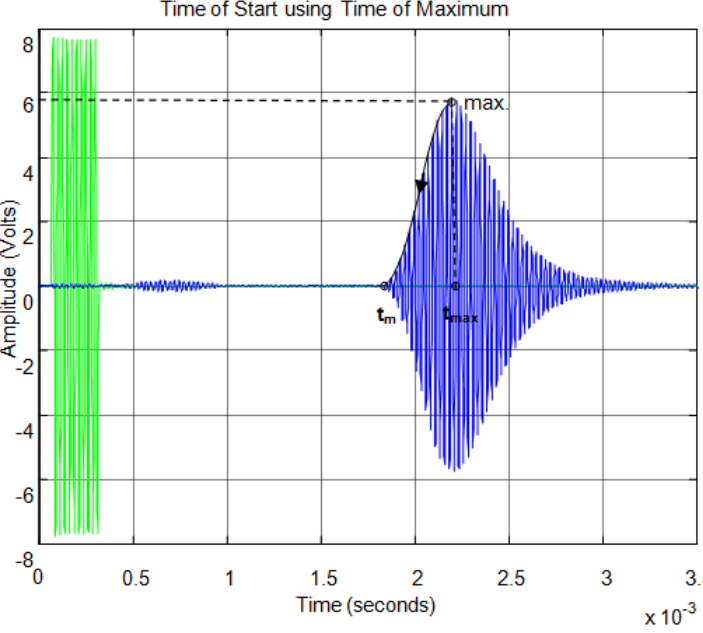
Figure 10. Example of emitted and received signal for a simple